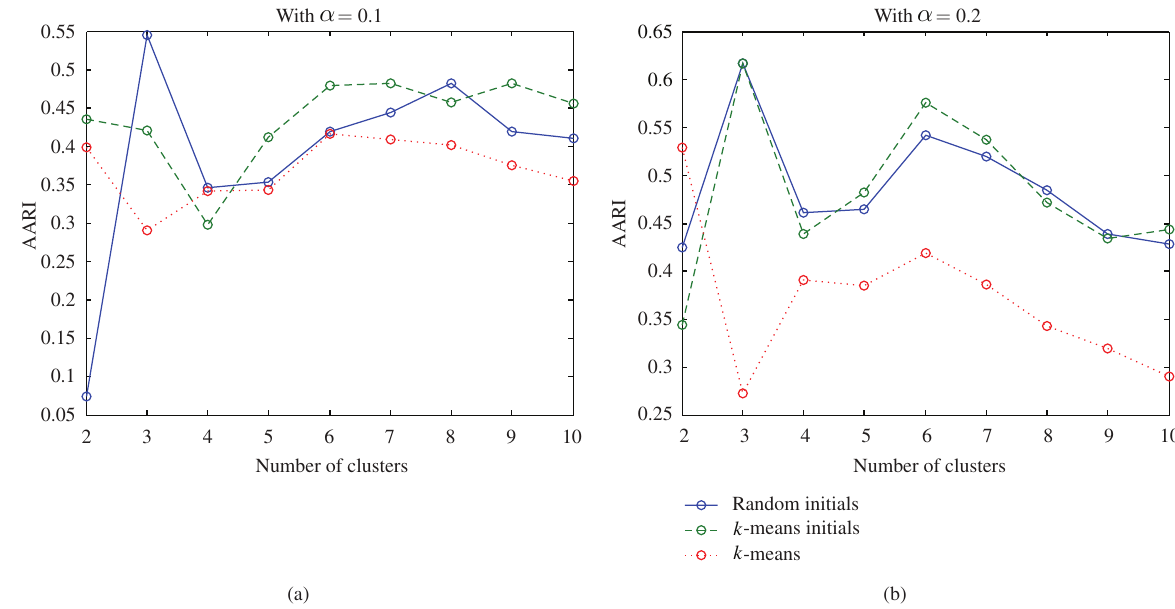
FIGURE 2: Plot of ARRI over different number of clusters for ELU after